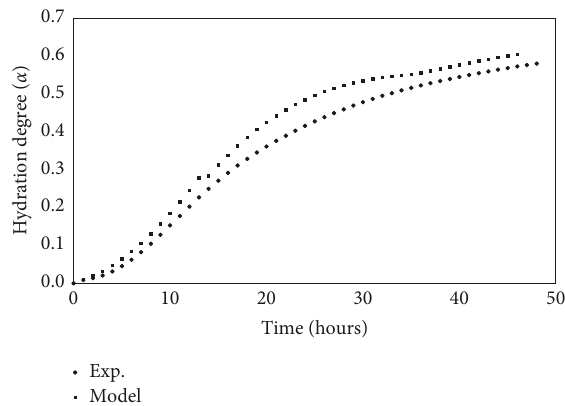
Figure 9: Experimental results of the hydration degree with the assumed kinetic model for sample C10SZ.